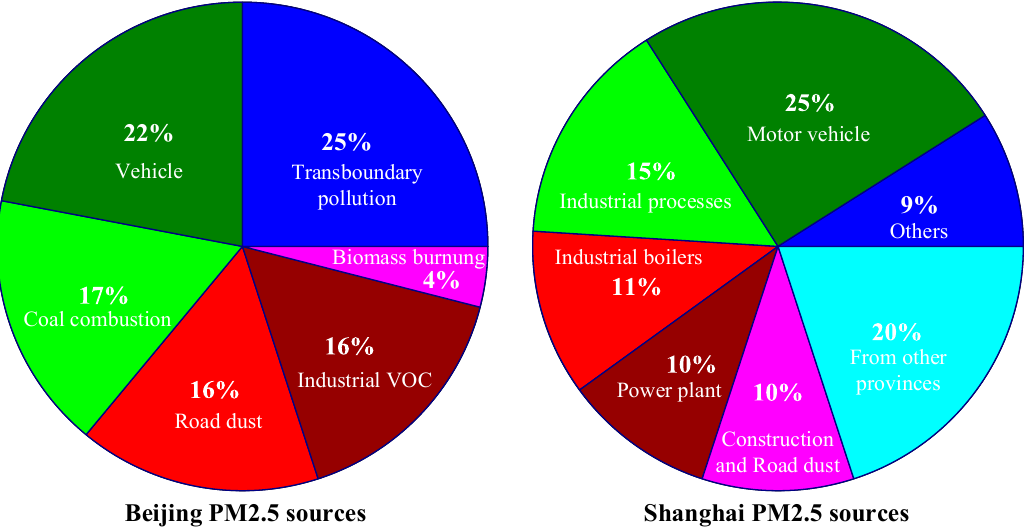
Figure 1. The Particulate Matter (PM)2.5 source pie charts of Beijing and Shanghai [20].